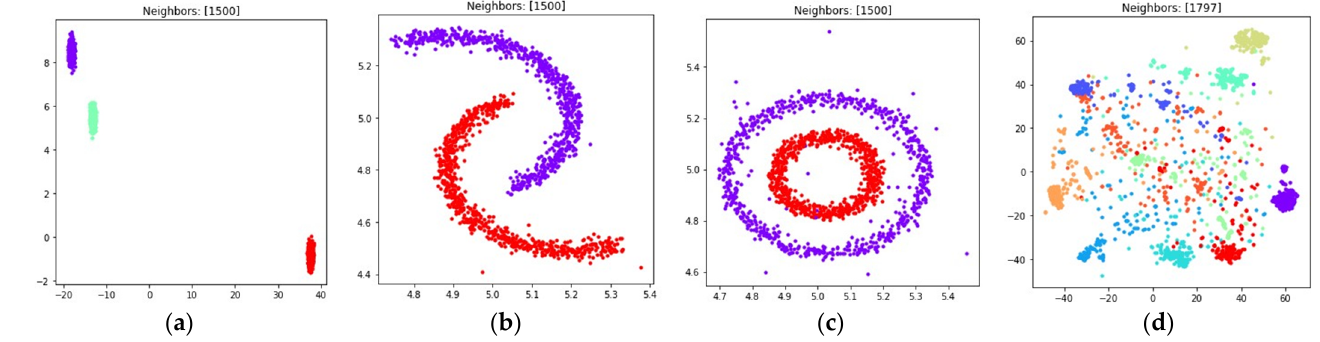
Figure 12. Locations of objects in R 2 with dimensionality reduction performed by applying the UMAP algorithm, with low dimensional embedding optimized by the Adam algorithm, modified fuzzy cross entropy loss, and the gradient (35) with d min set to 0.1 for: ( a ) blobs, k = 10; ( b ) moons, k = ( n − 1 ) ; ( c ) circles, k = ( n − 1 ) ; ( d ) handwritten digits, k = ( n − 1 )